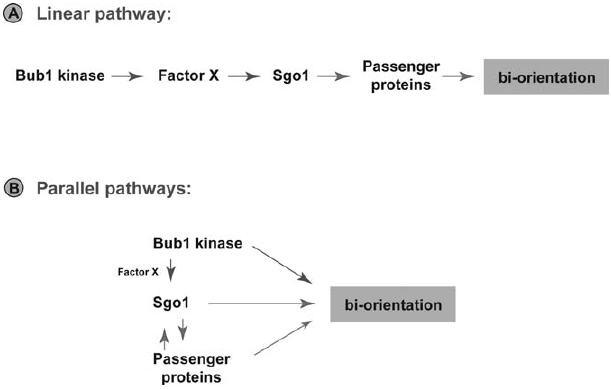
Figure 6. Models for Bub1 Kinase and Sgo1p Functions (A) Simple linear pathway: Bub1 kinase phosphorylates Factor X in such a way that Sgo1 is efficiently targeted to centromeres. This in turn ensures efficient recruitment of the Passenger proteins, which act to monitor and correct any inappropriate kinetochore-microtubule attachments. (B) Parallel pathways: Bub1 kinase, Sgo1p, and the Passenger proteins act in a concerted fashion to ensure efficient biorientation of sister kinetochores. This model better explains why localization of the different proteins are not entirely dependent upon one another. It also suggests that Bub1 kinase, and/or Sgo1p, might act to break inappropriate kinetochore attachments independently of Aurora kinase.